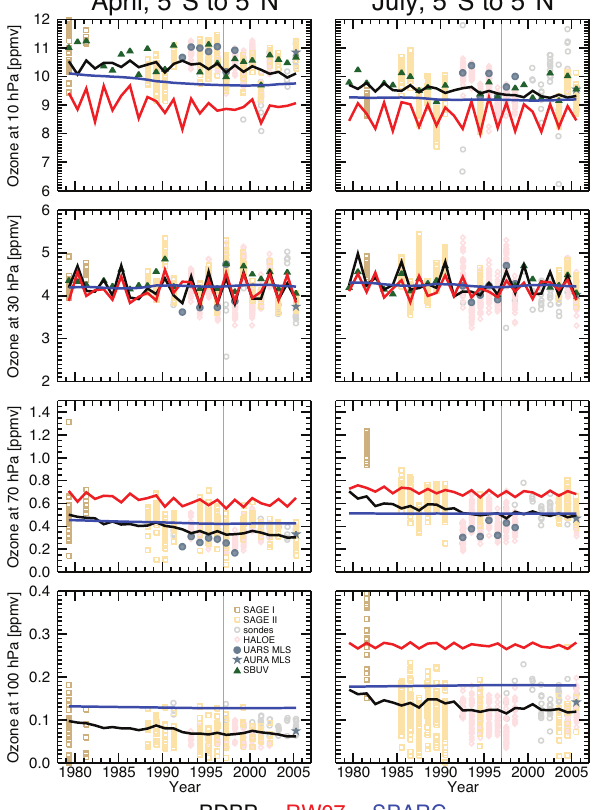
Fig. 6. April (left) and July (right) ozone time series between 5 ◦ S Figure 6. April (left) and July (right) ozone time series between 5°S to 5°N for four different 2 to 5 ◦ N for four different pressure levels. Individual ozonesonde pressure levels. Individual ozonesonde (grey open circles), SAGE I and II (orange open 3 (grey open circles), SAGE I and II (orange open squares), HALOE squares), HALOE (red open diamonds), and SBUV/SBUV2 (dark green, filled triangles), 4 (red open diamonds), and SBUV/SBUV2 (dark green, filled trian- gles), UARS MLS monthly means (dark grey, filled circles), AURA UARS MLS monthly means (dark grey, filled circles), AURA MLS monthly means (dark 5 MLS monthly means (dark grey, filled stars), and the BDBP (black), grey, filled stars), and the BDBP (Tier 1.4, black), RW07 (red) and SPARC (blue) time series 6 RW07 (red) and SPARC (blue) time series are shown. The vertical are shown. The vertical grey line denotes the inflection point selected for piecewise linear 7 grey line denotes the inflection point selected for piecewise linear trend calculations. trend calculations. 8